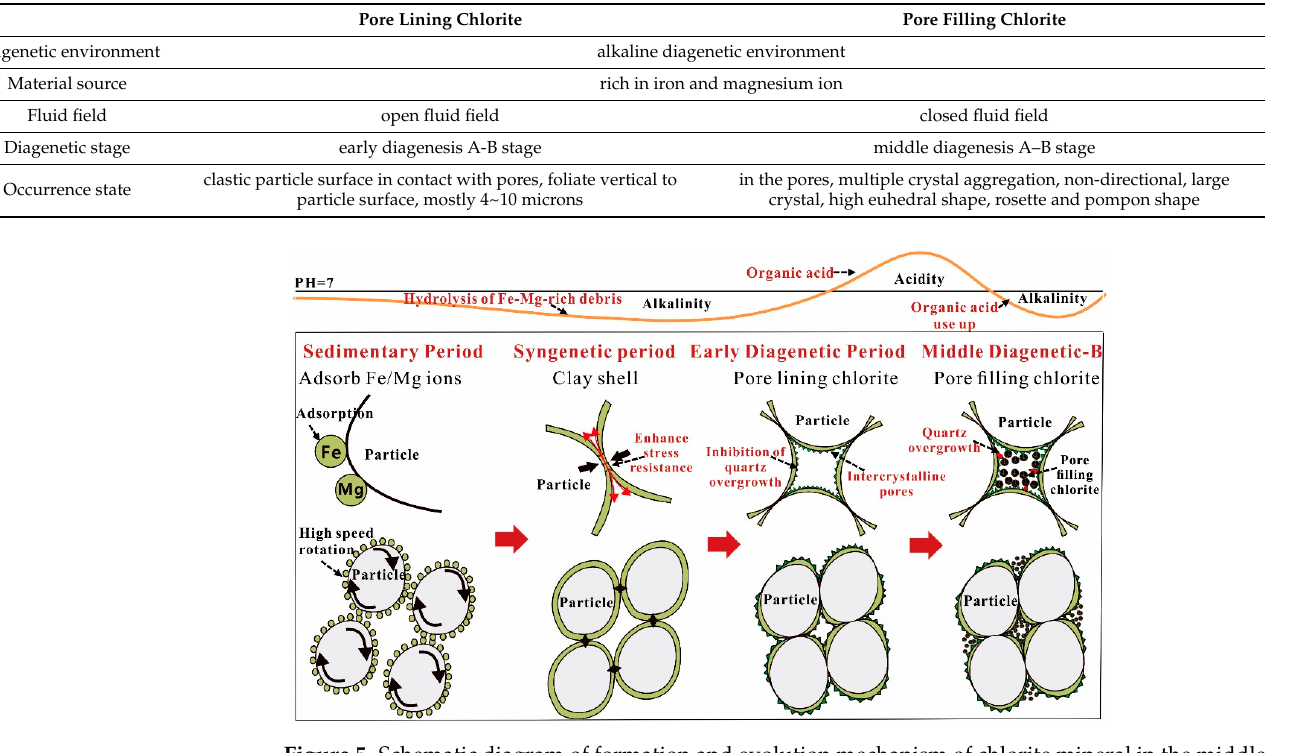
Figure 5. Schematic diagram of formation and evolution mechanism of chlorite mineral in the middle and north of the central inversion tectonic belt.